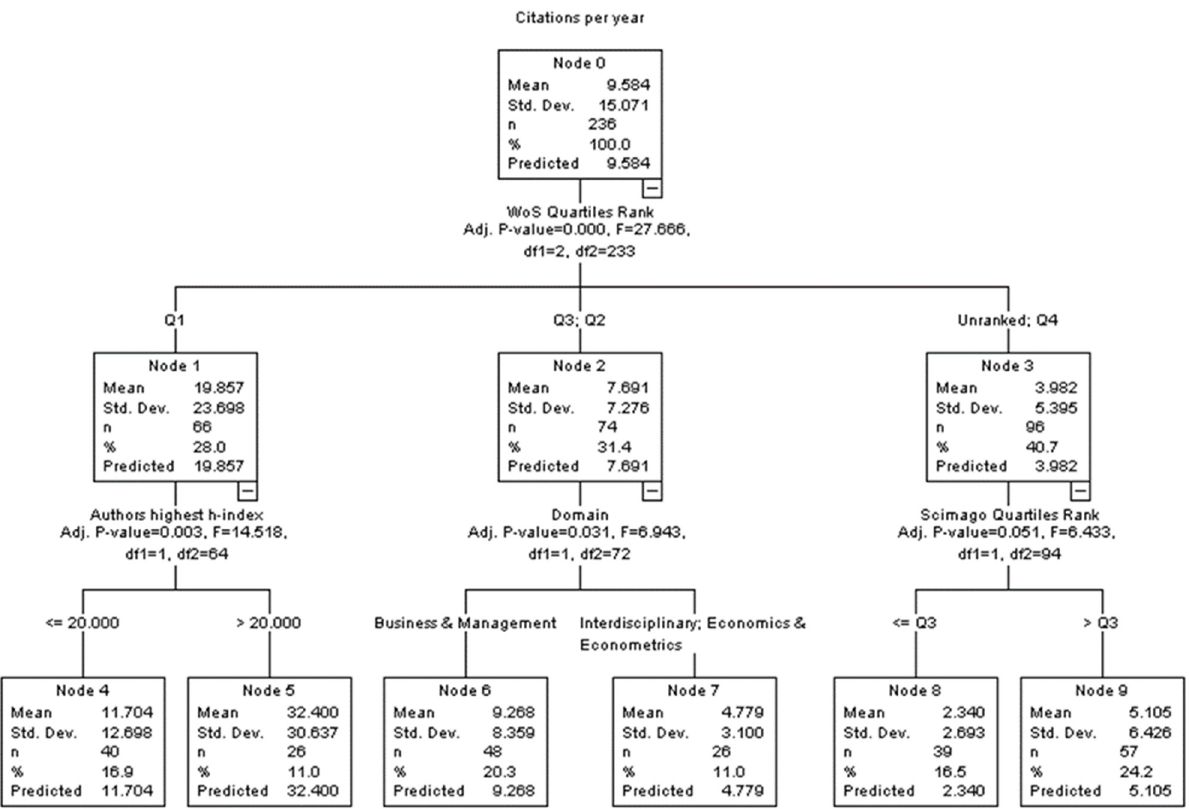
Figure 1. Results of CHAID analysis with all nodes splitting significantly at p ≤ 0.05.